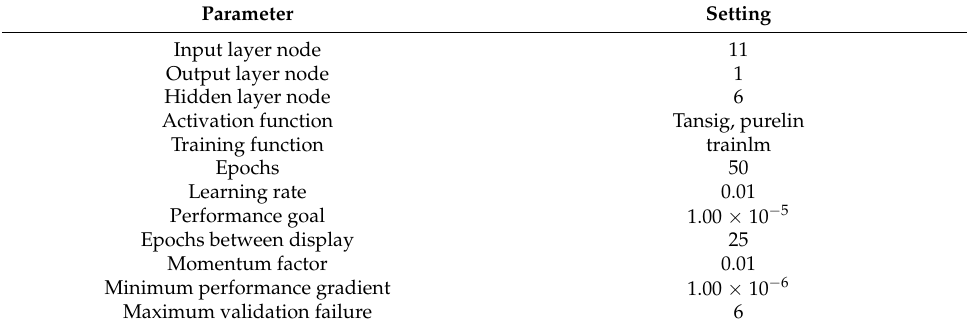
Table 2. Parameter setting of ANN